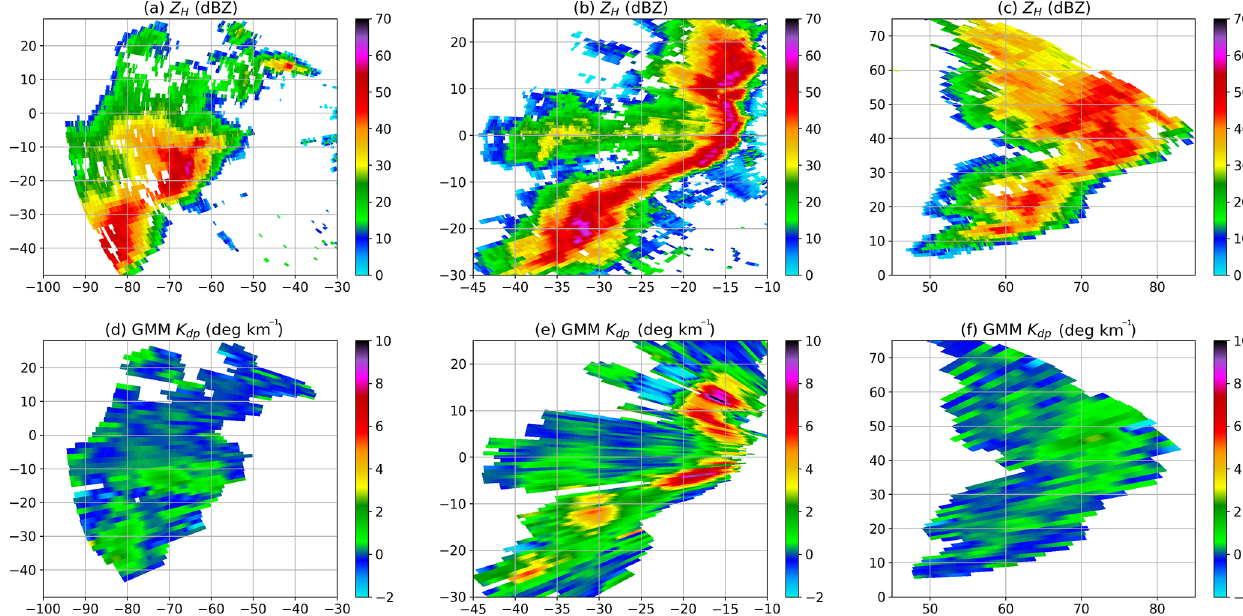
Figure 8. A case study for GMM: (a) raw Z H at the development stage (03:04UTC), (b) raw Z H at the mature stage (03:39UTC), and (c) raw Z H at the dissipation stage (04:41UTC). (d) , (e) , and (f) are the same as (a) , (b) , and (c) , respectively, but for K dp . The data were collected at a elevation of 0.85 ◦ by the MZZU radar between 03:04 and 04:41UTC on 24 March 2016.